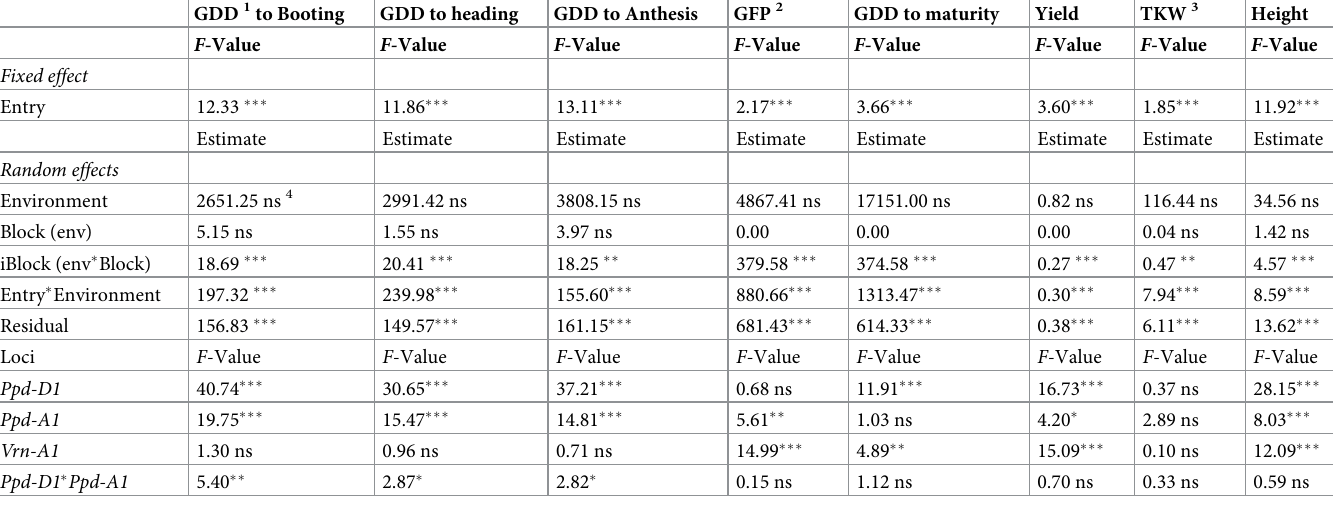
Table 3. Mixed model analysis of variance of 208 genotypes in a diversity panel for phenotypic traits observed in 2015 and 2016 field trials planted in Elora and Woodstock Ontario locations. (Fixed effect DF = 207, Loci effect DF =